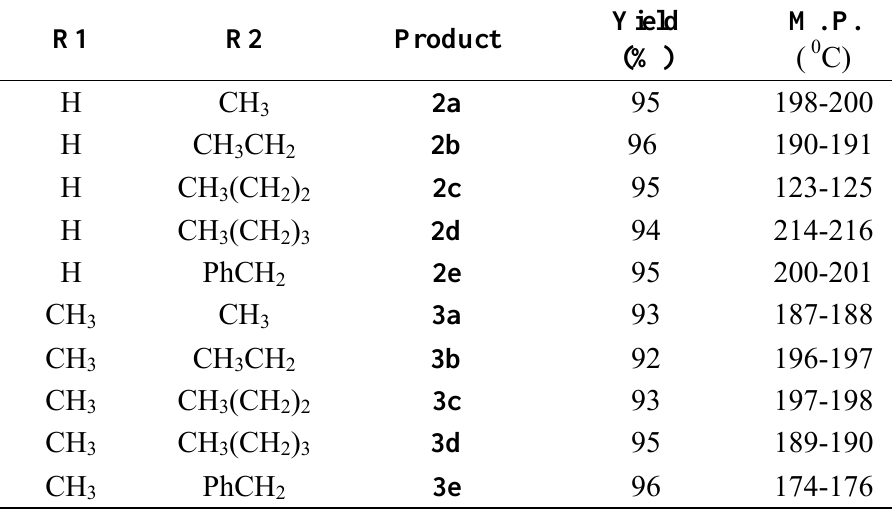
Table 1. Yield and melting points for 2a-e and 3a-e